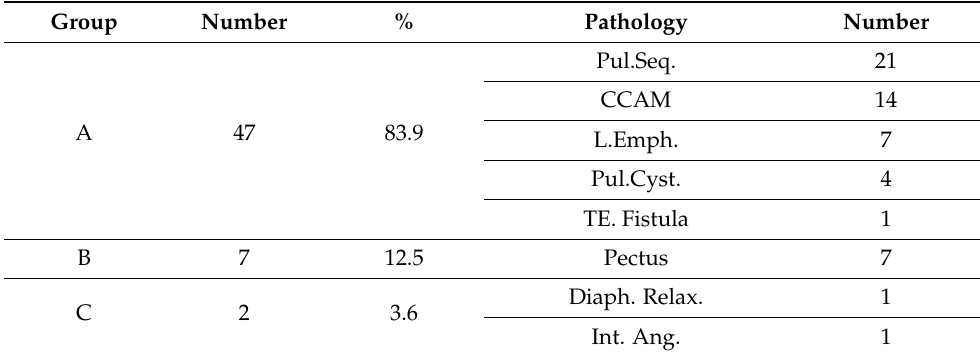
Table 1. Disease division